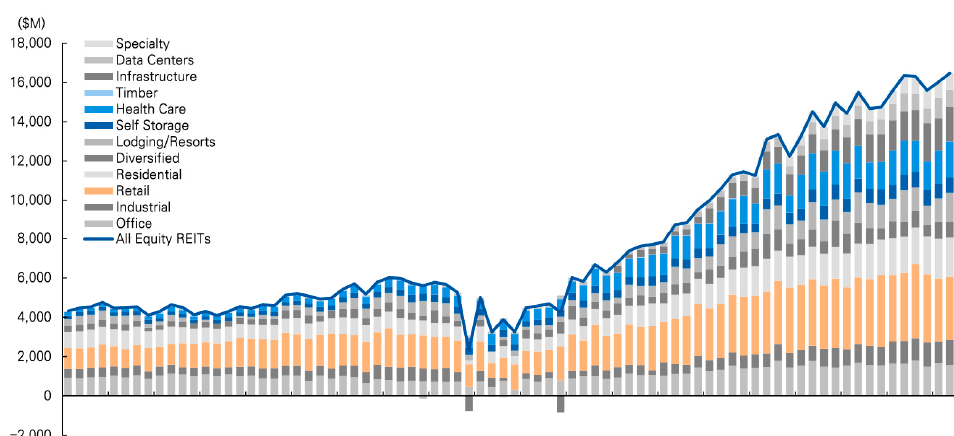
Figure 2. Global REITs (real estate investment trusts).